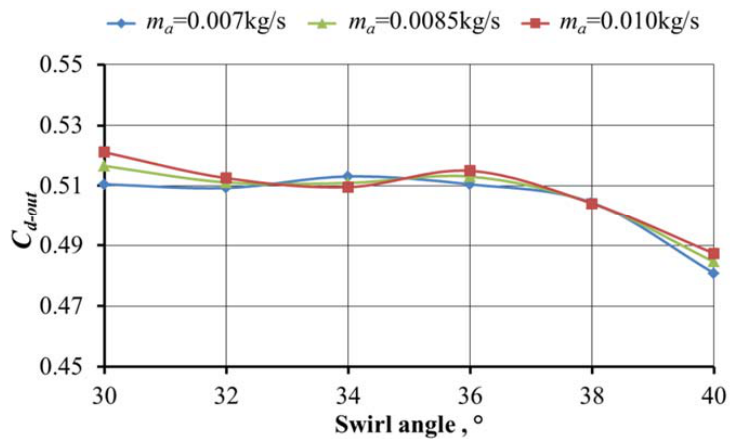
Figure 8. The effect of swirl angle on discharge coefficient of convergent outlet.